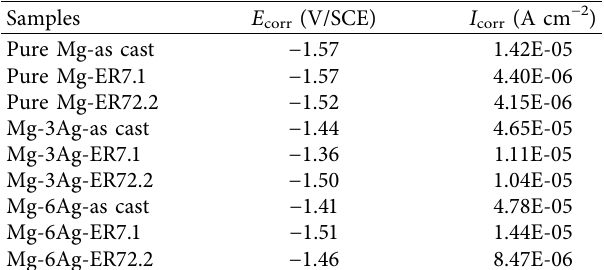
Figure 3: Tafel curves for pure Mg and Mg-Ag alloys after immersion in DMEM+10% FBS for 1 day. Table 3: Electrochemical parameters of pure Mg and Mg-Ag alloys after immersion in DMEM+ 10% FBS for 1 day.